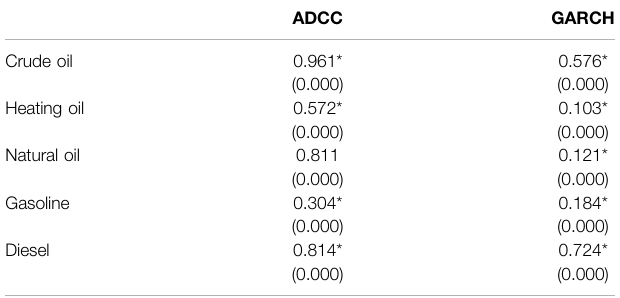
TABLE 6 | Empirical results of ADCC-GARCH estimates. TABLE 7 | Robustness estimates: CO-GARCH